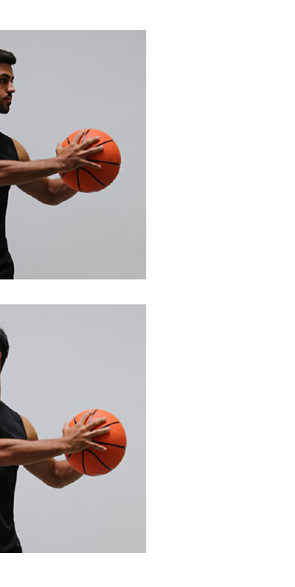
Participants sat approximately 60 cm in front of the monitor and were instructed to respond to the pass direction of the basketball player as fast and as accurately as possible by pressing the left or right response button. One trial consisted of a fixation cross (500 ms), the basketball player in the initial position (1000 ms), the head turn to one side (social cue; presentation duration in dependence of SOA), and the target with the basketball player executing the pass (until response; see Fig 2). The stimulus-onset asynchrony (SOA) between the head turn, and the pass was varied between 0 and 800 ms, in steps of 100 ms. In the SOA 0 condition, no